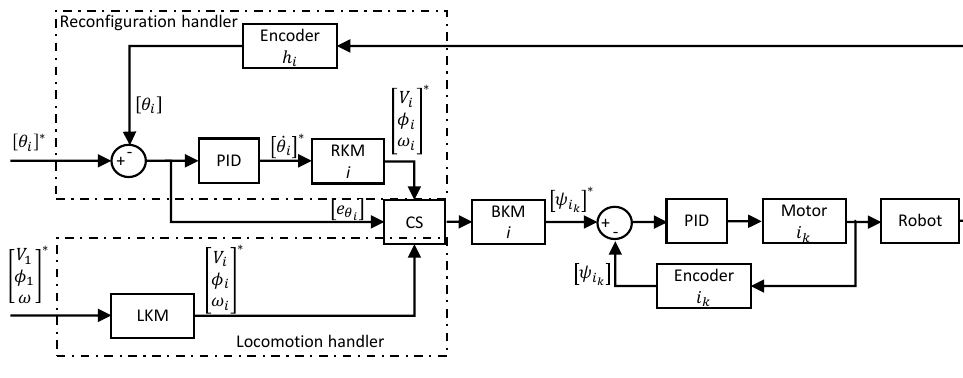
Figure 5. Control